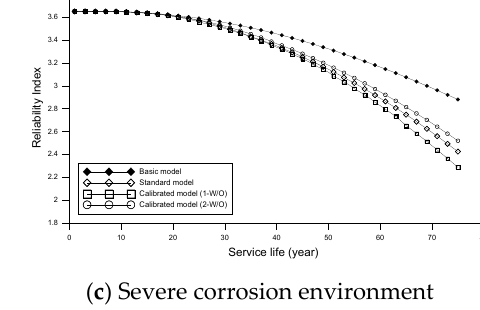
Figure 11. Reliability degradation under light traffic characteristics (without previous inspection).